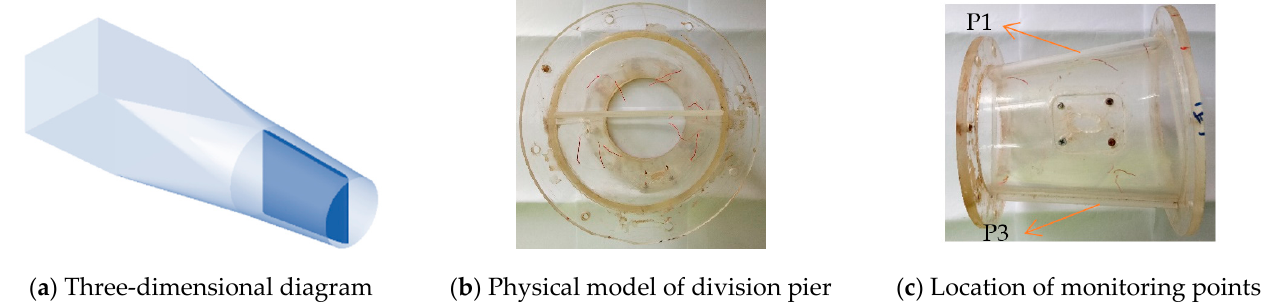
Figure 18. The physical picture of the test section of the straight outlet conduit with division pier. The comparison results of the energy values of the two monitoring points with and without a division pier are shown in Figure 19. The results show that the energy values of the two monitoring points in the straight outlet conduit decreased with the decrease of the flow rate with or without the division pier, and the energy values of the two monitoring points in the straight outlet conduit with the division pier were less than those without the division pier. When the flow coefficient was less than 1.0, the smaller the flow coefficient, the more obvious the influence of the division pier on the energy value of the monitoring point in the straight outlet conduit test section. When the flow coefficient was greater than 1.0, the greater the flow coefficient, the smaller the influence of the division pier on the energy value of the monitoring point in the straight outlet conduit test section. The reasonable setting of the division pier is conducive to reducing the pressure pulsation in the straight outlet con- duit and to the safe and stable operation of the pump device. According to the energy analy- sis results of the wavelet packet decomposition of the flow pulsation measuring points in the straight outlet conduit without a division pier, the energy proportion of the sub-band 0~31.25 Hz was the largest, and thus the power spectrum of the time domain signal of the sub-band was analyzed after reconstruction; the comparison of the power spectrum of the reconstructed time domain signal of the two monitoring points in the straight outlet conduit with and without a division pier is shown in Table 3.